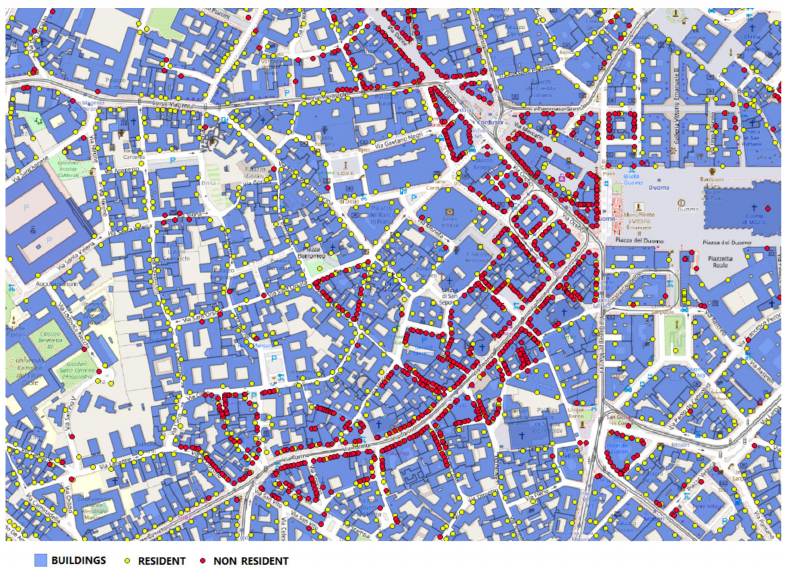
Figure 5. Building area and types of occupants.